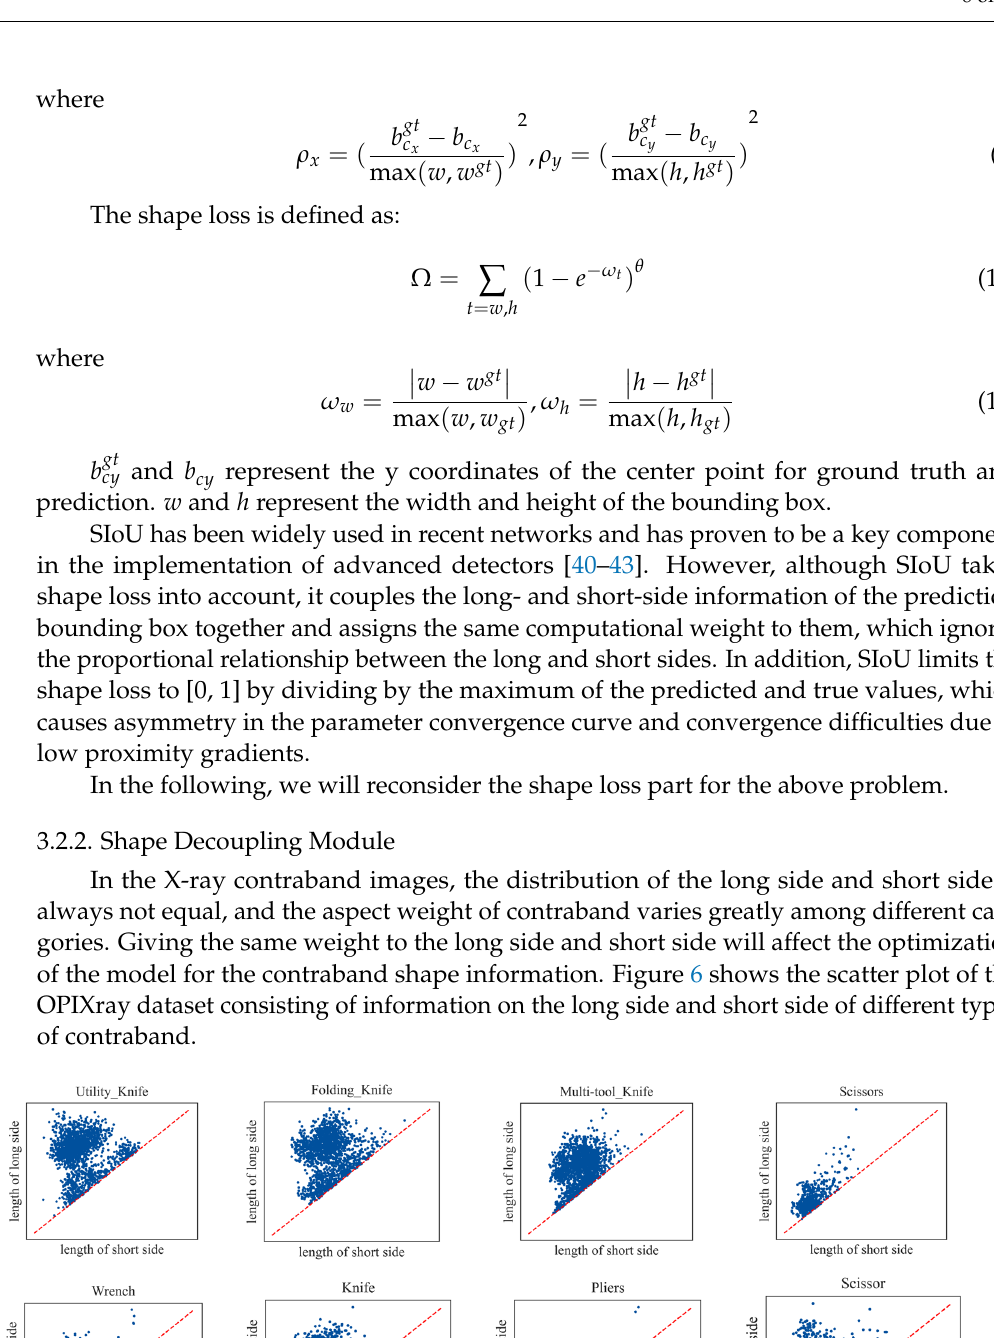
Figure 7. SD-SIoU structure diagram.